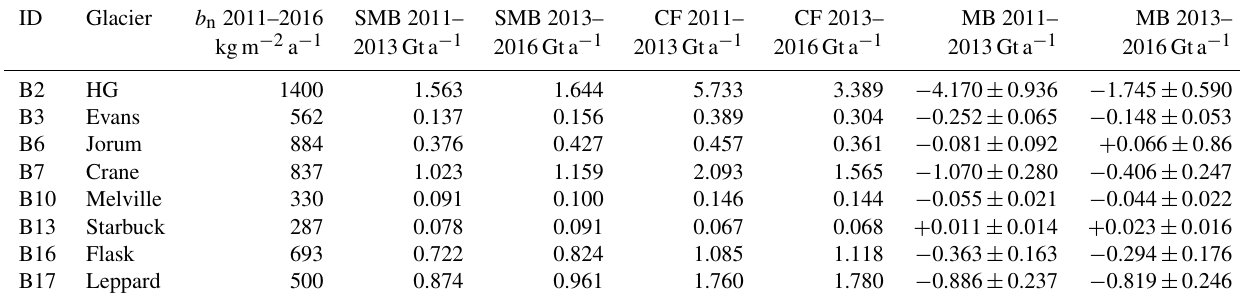
Table 7. Mean specific surface mass balance ( b n ) in 2011–2016, annual surface mass balance (SMB) and calving flux (CF) in 2011–2013 and 2013–2016 and resulting mass balance (MB) in Gta − 1 for Larsen B